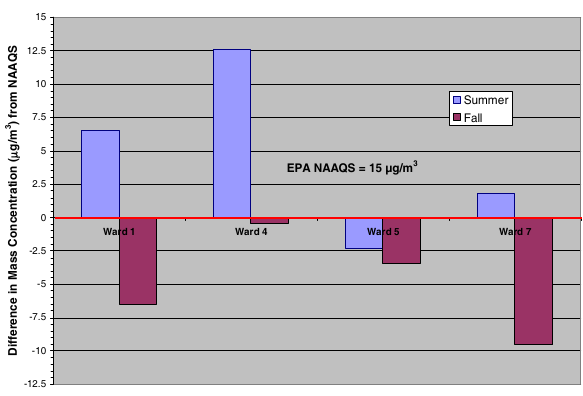
Mean Mass Density versus NAAQS Figure 3: PM 2.5